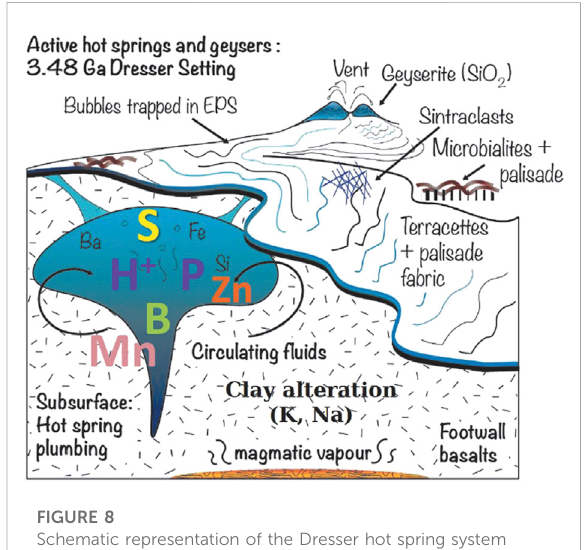
FIGURE 8 Schematic representation of the Dresser hot spring system and the elements it concentrated in hot spring pools and in the altered footwall (after van Kranendonk et al.,